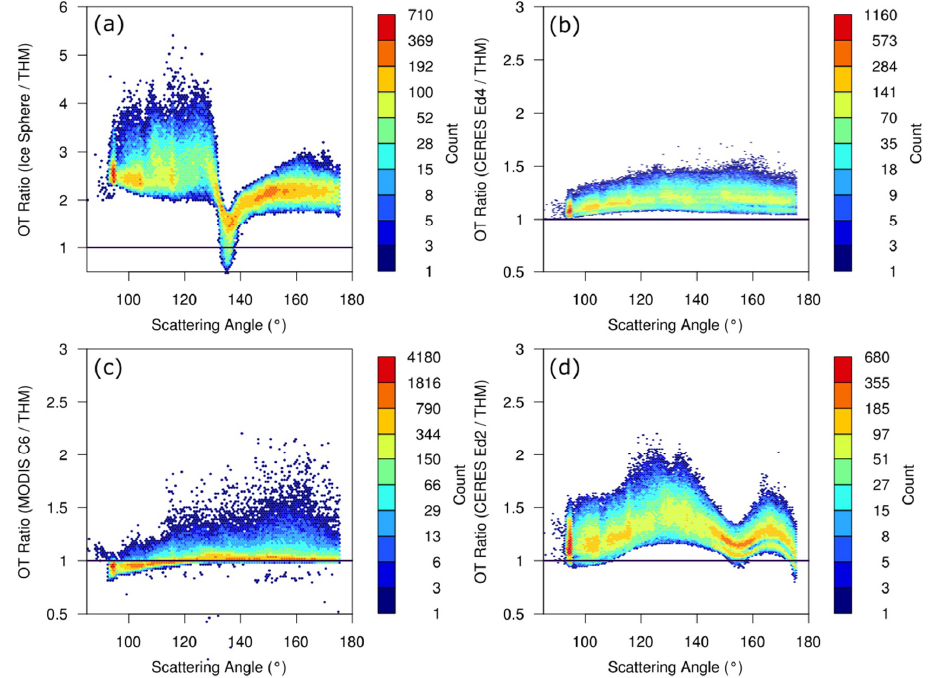
Figure 19. Ratio of retrieved optical thickness values to that of the two-habit model with retrieval results from the shortwave bi-spectral method: ( a ) ice sphere to two-habit model (THM; potential CERES Edition 5 model); ( b ) CERES Edition 4 model to two-habit model; ( c ) MODIS Collection 6 model to two-habit model; and ( d ) CERES Edition 2 model to two-habit model.